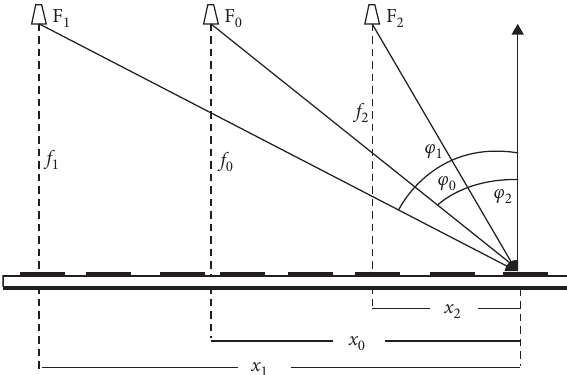
Figure 3: Reflection phase from different feed points in a planar